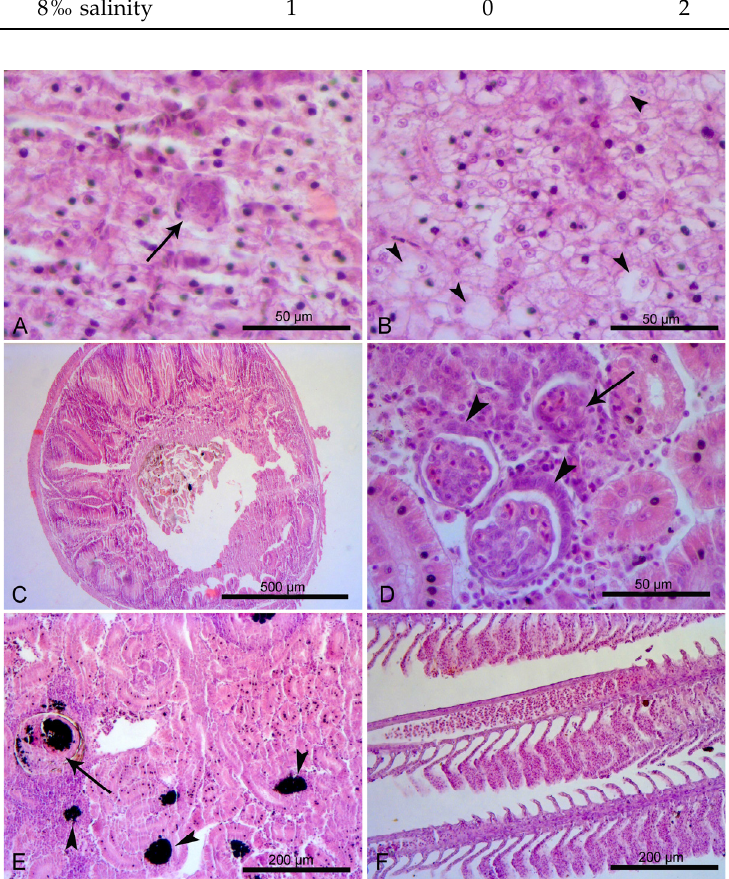
Figure 1. ( A ) Salinity 20 ppt: liver micro-granuloma (arrow). ( B ) Salinity 14 ppt: lipid accumulation in the liver cells (arrowheads). ( C ) Salinity 20 ppt: structure disorganization of the midgut. ( D ) salinity 20 ppt: Bowman’s capsule epithelial cells proliferation (arrowheads) and glomerulopathy (arrow). ( E ) Salinity 14 ppt: kidney granuloma (arrow) with many melanomacrophage centers indicated with arrowheads. ( F ) Salinity 8 ppt: telangiectasia of the gills’ secondary lamellae.